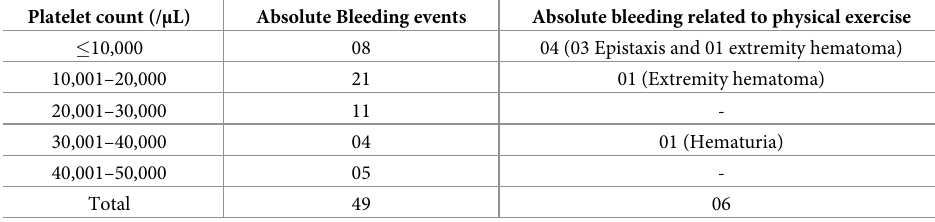
Table 2. Bleeding events according to platelet count. Platelet count (/ μ L) Absolute Bleeding events